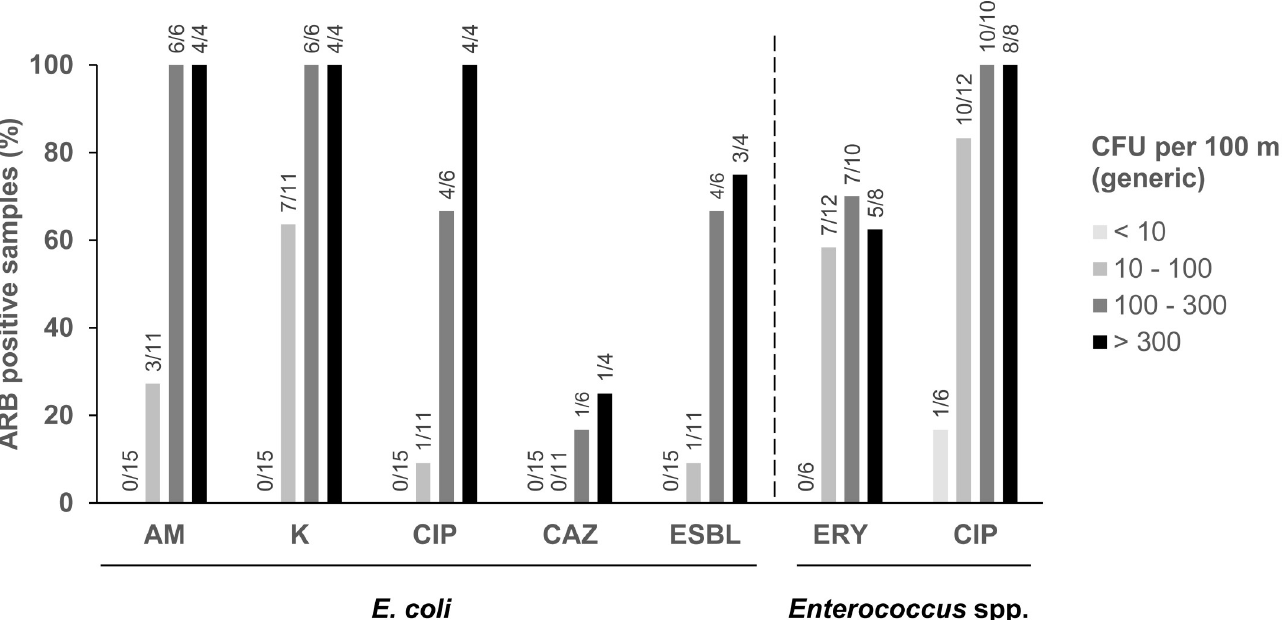
Fig 2. Generic E . coli or Enterococcus spp. counts and frequency of ARB-positive irrigation water samples. With increasing generic E . coli or Enterococcus spp. counts, water samples containing different ARB of the respective species were more frequent. AM, ampicillin; K, kanamycin; CIP, ciprofloxacin; CAZ, ceftazidime; ERY, erythromycin. Numbers on top of bars indicate number of positive to total water